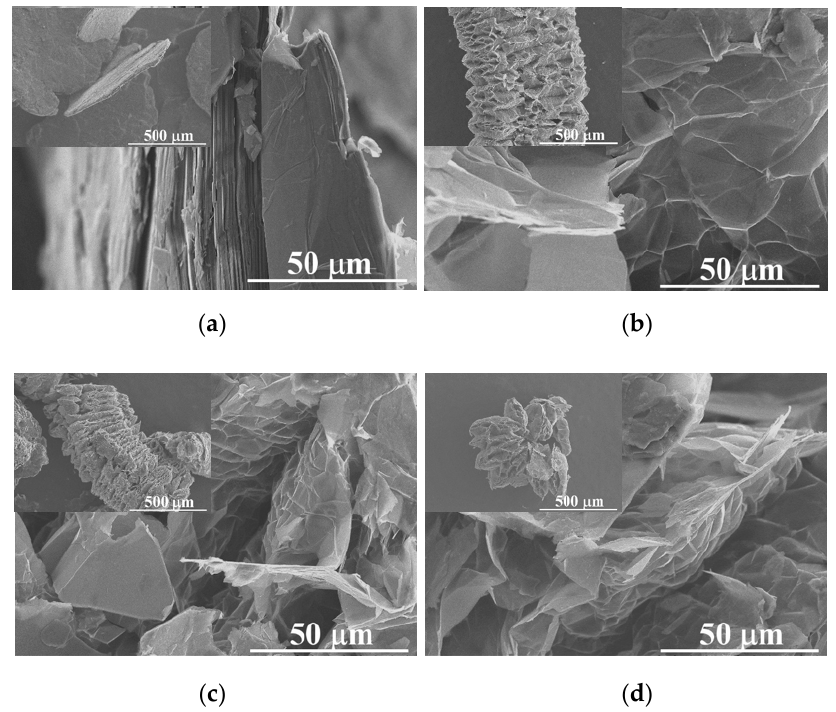
Figure 1. SEM micrographs (100 and 1000X) of a single particle of ( a ) raw graphite (NGr) and intercalated products ( b ) 0–2, ( c ) 5–2, and ( d ) 15–2.